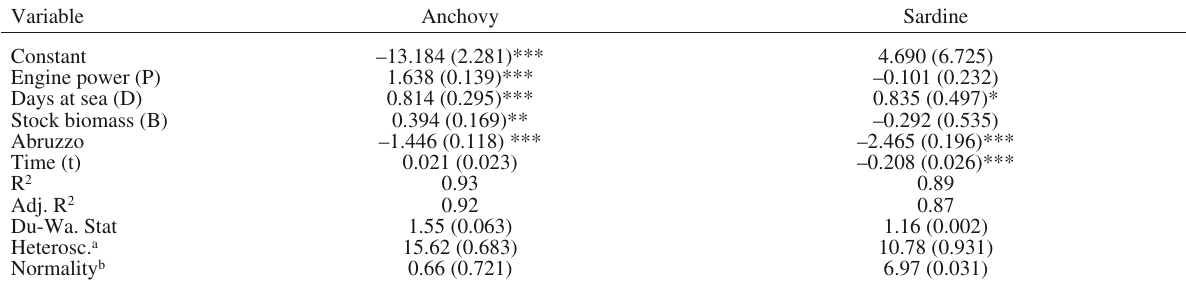
Table 2. – Estimated production function coefficients and test results on residuals. The values within parentheses are standard errors. Significance level: * 10%; ** 5%; *** 1%.